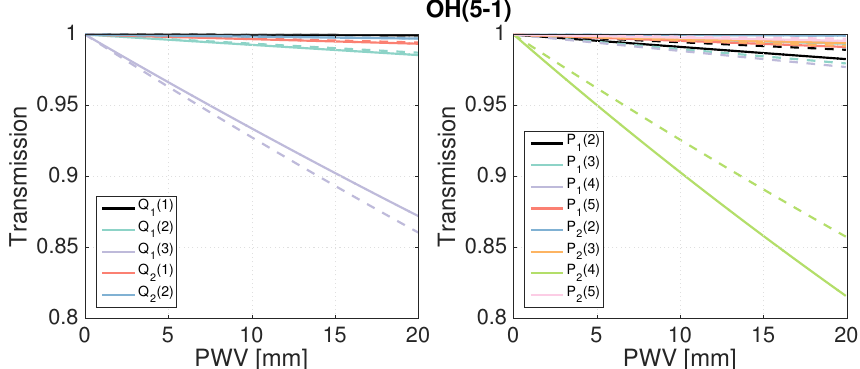
Figure 5. Water vapour transmission of the OH(5–1) lines as a function of precipitable water vapour (PWV). The left panel shows the Q-branch lines and the right panel, the P branch. Solid lines represent the e component of the lambda-doubled line, and the dashed lines represent the f component.